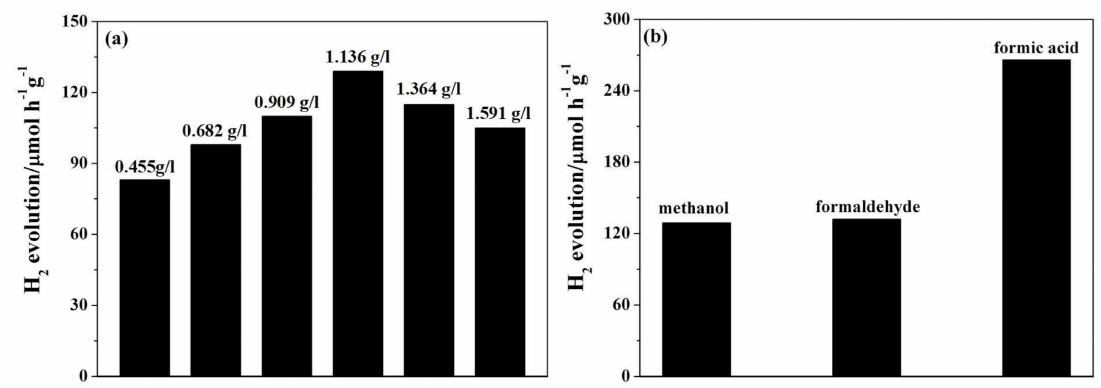
Figure 5. ( a ) Effect of the concentration of the photocatalyst on hydrogen production over the Bi 4 Ti 3 O 12 − x (350 ◦ C, 60 min) nanosheets under visible-light irradiation ( λ > 400 nm); and ( b ) Effect of various wastes as additives on hydrogen production over the Bi 4 Ti 3 O 12 − x (350 ◦ C, 60 min) nanosheets under visible-light irradiation ( λ > 400